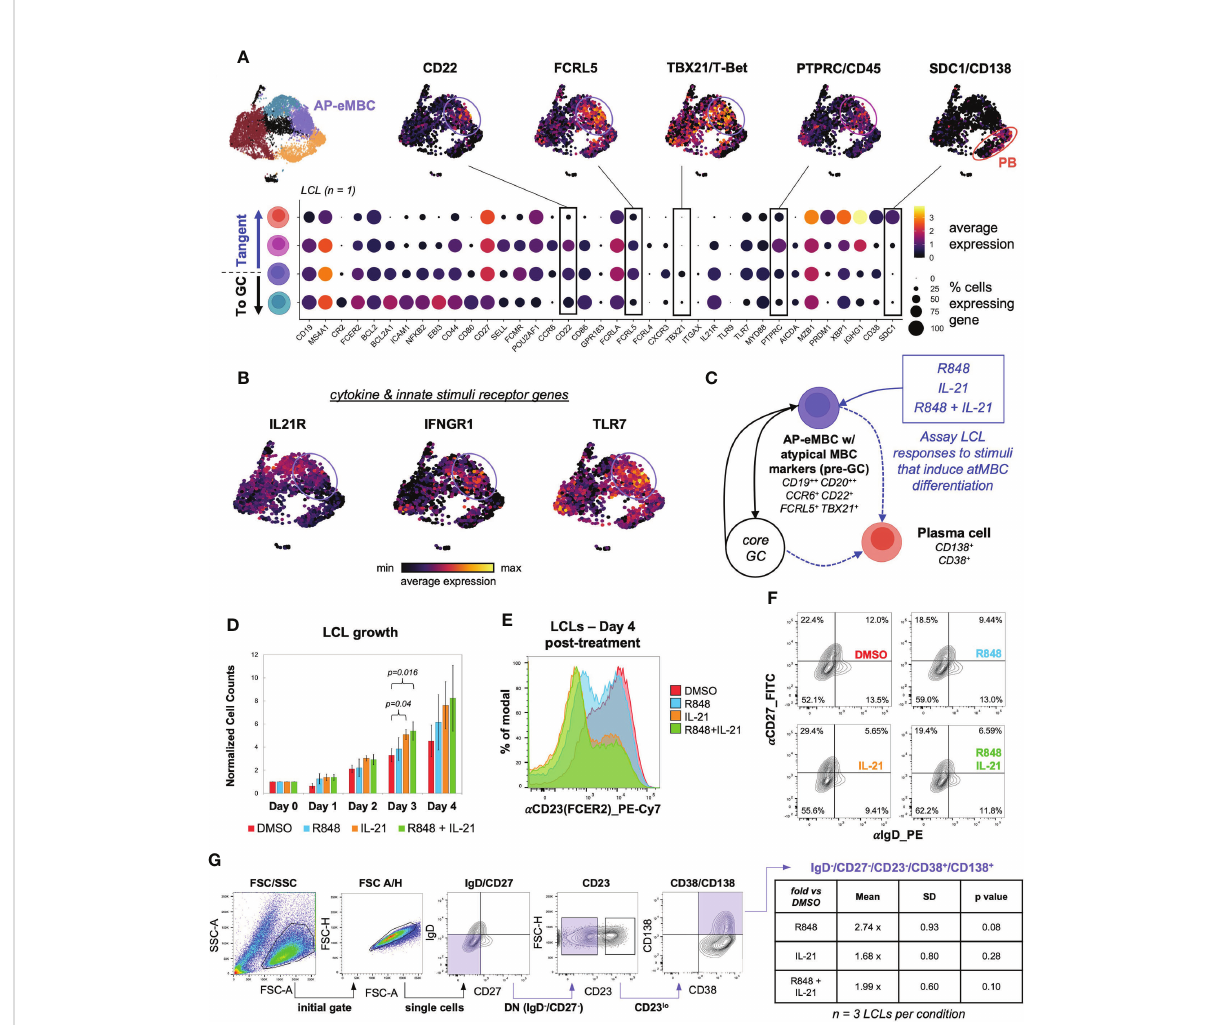
FIGURE 6 An EBV + pre-GC activated state with hallmarks of T-bet + memory B cells develops in a subset of LCLs. (A) AP-eMBC cluster cells within one in- house LCL dataset exhibits an atypical memory B cell (atMBC) phenotype prone to plasma differentiation. (B) Upregulation of genes encoding receptors for IL-21, IFNG, and TLR7 ligands within identi fi ed LCL atMBCs coincide with the AP-eMBC phenotype. (C) Model experimental design to stimulate plasma cell differentiation from AP-eMBC/atMBCs within LCLs. (D) Growth analysis of LCLs treated with 2 m g/mL TLR7 agonist R848 (blue), 10 ng/mL IL-21 (orange), or both (green) versus control treatment (0.1% DMSO, red). Data are presented as mean +/- standard deviation cell counts with intra-replicate normalization to Day 0 across 3 biological replicates per condition. Statistically signi fi cance of differences (Day 3 IL-21 vs. DMSO, p = 0.04 and Day 3 R848+IL-21 vs. DMSO, p = 0.016) were calculated using Welch ’ s t test (two-tailed, paired). (E) Representative CD23 (FCER2) expression in LCLs at Day 4 by treatment group. (F) CD27 and IgD staining of LCLs at Day 4 by treatment group to evaluate the frequency of EBV-infected double-negative (DN) B cells (IgD - /CD27 - ). (G) Gating strategy to identify DN B cell-derived plasma cells (IgD - /CD27 - /CD23 - /CD38 + /CD138 ++ ) and quanti fi cation by treatment relative to control treated LCLs at Day 4. Statistical signi fi cance was evaluated by Welch ’ s two-tailed